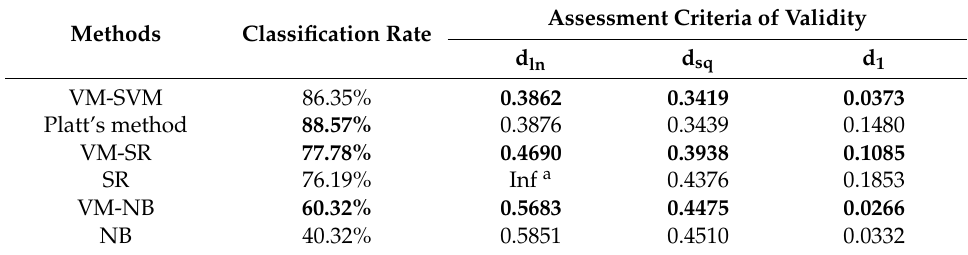
Table 2. Classification rates and assessment criteria of validity of probabilistic prediction results for ginseng samples by each method.